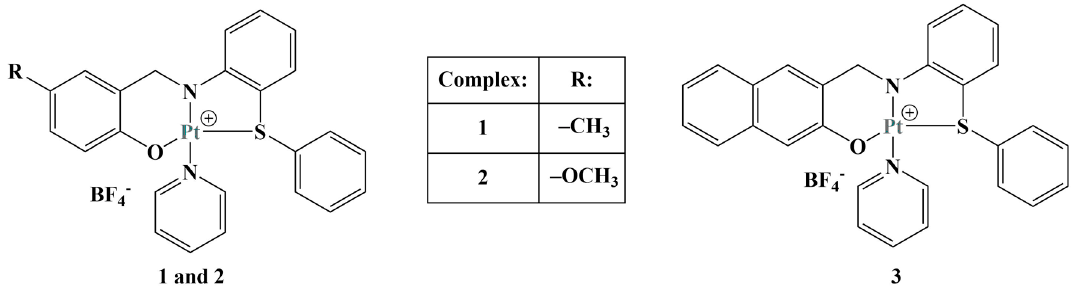
Figure 8. The complexes described in [33].